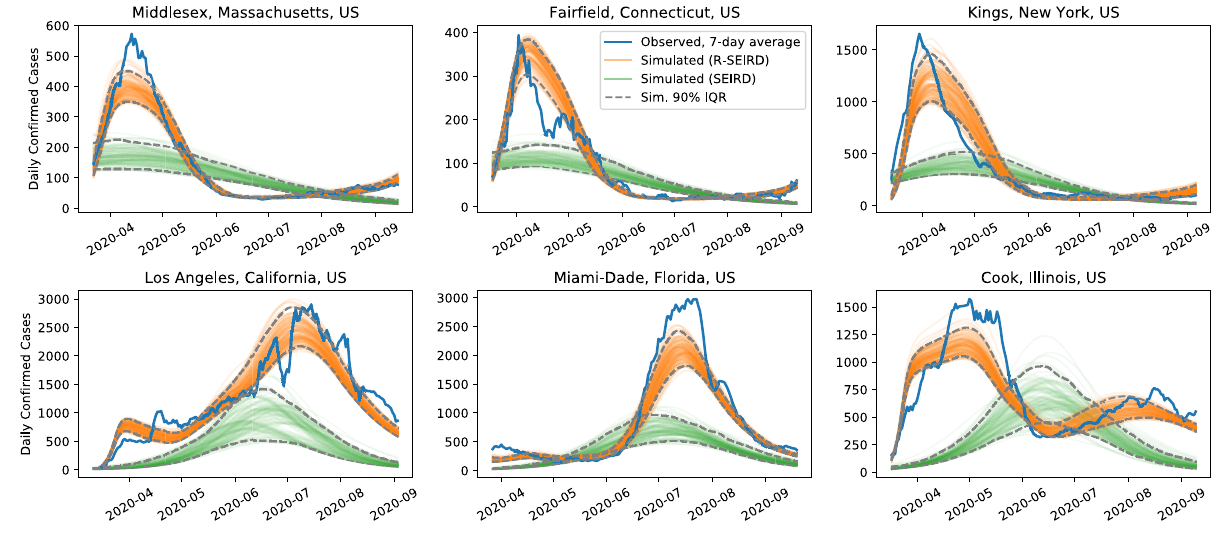
Figure 1. Simulations of the learned R-SEIRD and learned SEIRD systems on the six counties the models are trained on. The trajectory in blue is the 7-day moving average of observed daily confirm cases. These results demonstrate the expressiveness of our model. In particular, our model (orange) is able to track observed disease progression (blue) much closer than the canonical SEIRD model (green). In addition, it is able to identify the observed multiple peak behavior for which SEIR is not designed to capture. These results are consistent across diverse geographic areas of US.